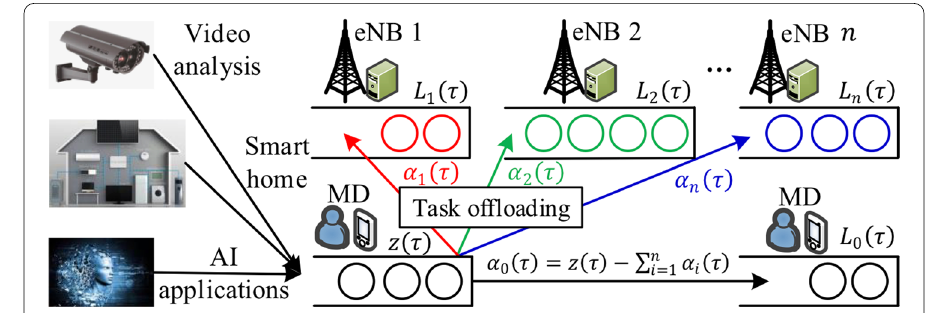
Fig. 1 The task offloading architecture in multi-eNB